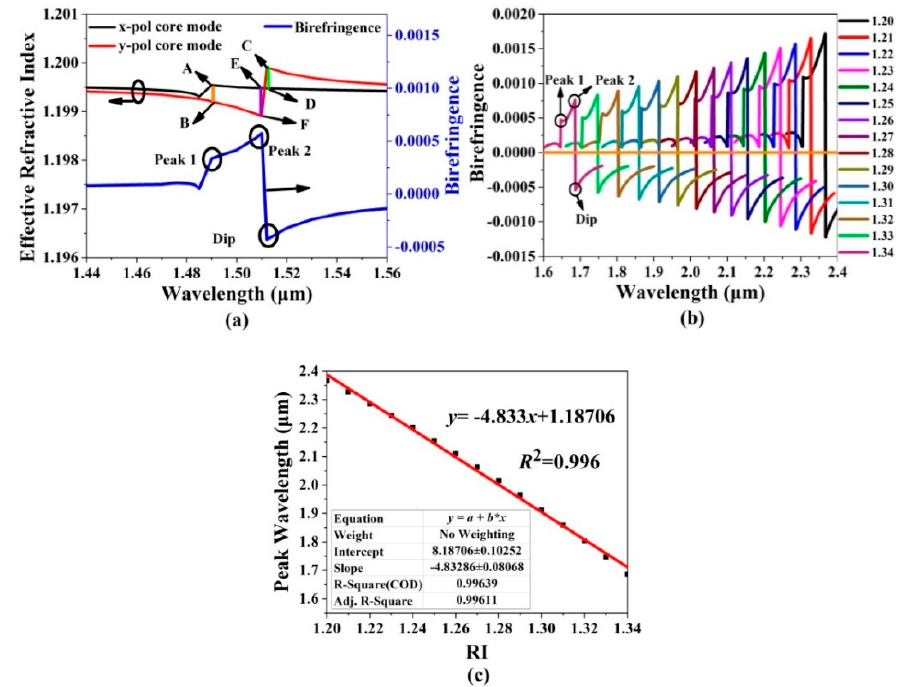
Figure 8. ( a ) The effective RI and birefringence curves of the gold wires-filled HC-NCF when the initial structure parameters of the HC-NCF are set as r 1 = 6.7 μ m, t 1 = 0.5 μ m, r 2 = 6.0 μ m, t 2 = 0.5 μ m, r 3 = 8.25 μ m, t 3 = 0.9 μ m, and D = 62 μ m, respectively, and the RI of the filled analyte is chosen as 1.20, ( b ) the birefringence curves of the x -pol and y -pol core modes of the gold wires-filled HC-NCF when the RI of the filled analyte changes from 1.20 to 1.34, and ( c ) the variation in the confinement loss peak wavelength and linear fitting in the considered RI range of 1.20 to 1.34.